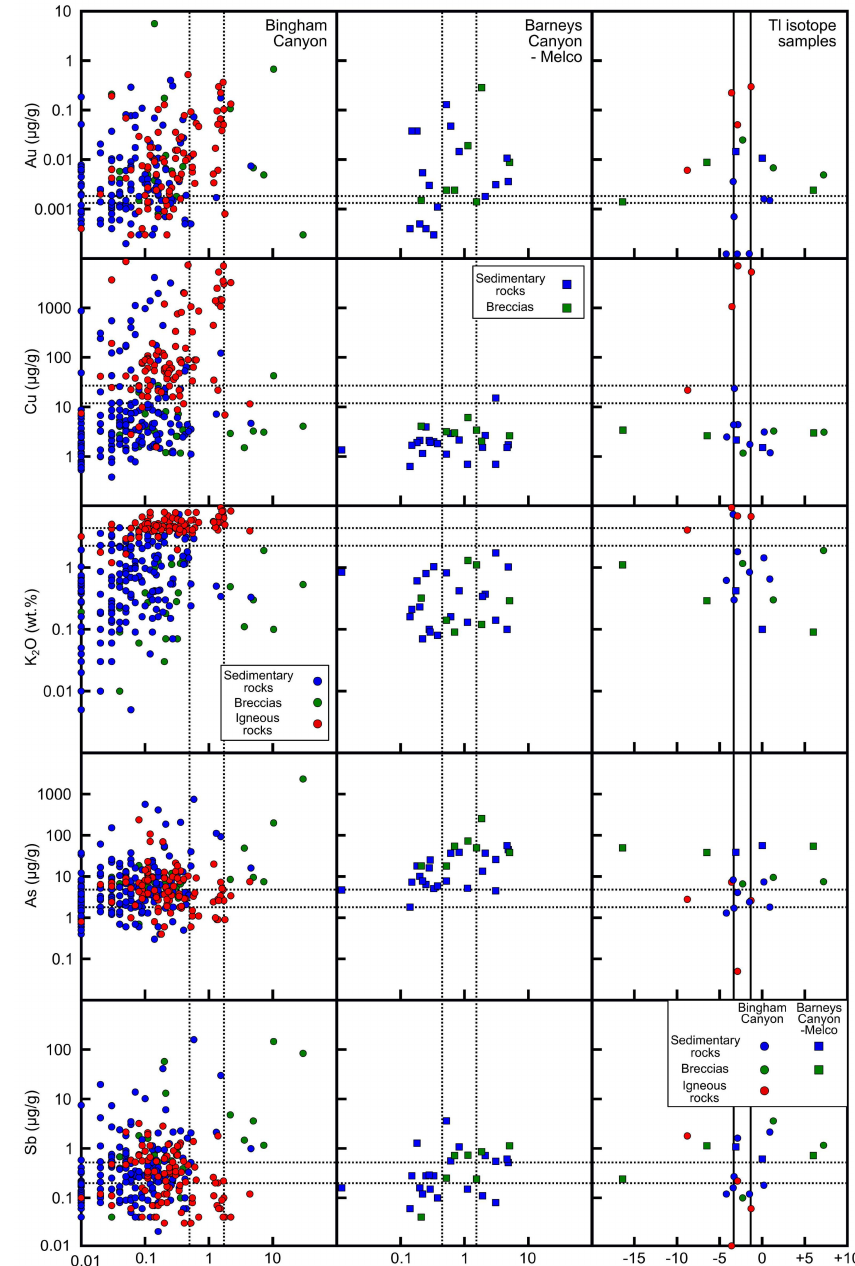
Figure 5. Plots of Au ( µ g/g), Cu ( µ g/g), K 2 O (wt.%), As ( µ g/g), and Sb ( µ g/g) against Tl ( µ g/g) and ε 205 Tl values measured in this study for the Bingham Canyon area (left column), the Barneys Canyon-Melco area (centre) and for samples analysed for Tl isotopes (right column); symbols as in Figure 4; dotted lines indicate range of continental crust abundance estimates [61]; solid lines in ε 205 Tl plots indicate mantle range [31,41]; geochemical data reported in the Supplementary